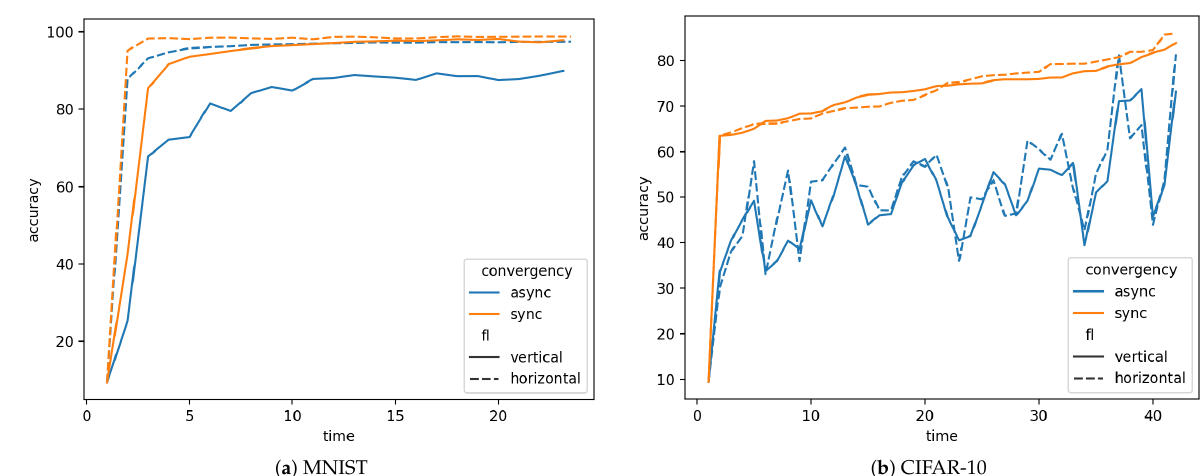
Figure 4. Asynchronous vs.